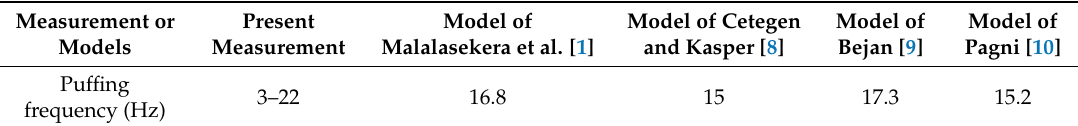
Table 2. The calculated results of flickering frequency with theoretical